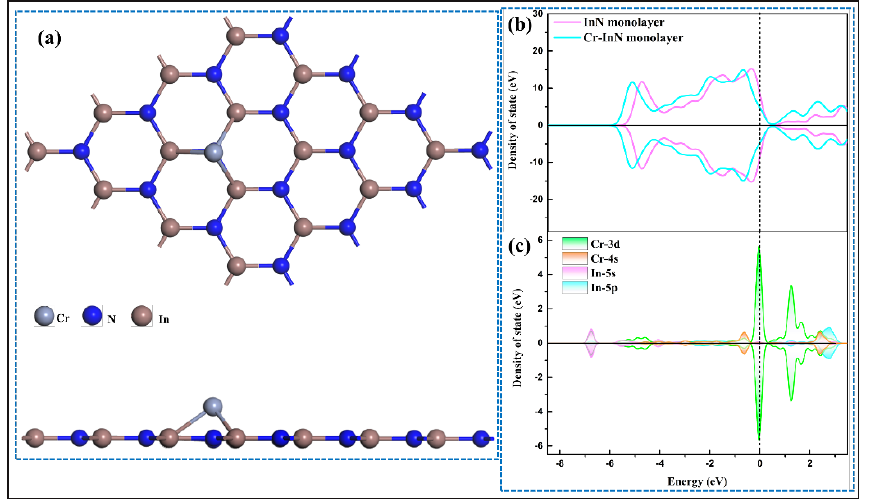
Figure 2. ( a ) Geometric structure, ( b ) TDOS, and ( c ) PDOS of Pd-doped InN monolayer. DOS analysis was used to explore the effect of Cr atom doping on electronic distri- bution. It is believed that TDOS can reflect the electron density distribution of a system; as shown in Figure 2b, the electrons of the Cr – InN monolayer moved to a slightly lower energy direction compared to those of the intrinsic InN monolayer. Moreover, some new states were added to the Cr – InN monolayer, which narrowed the intercept near the Fermi level of the TDOS curve of Cr – InN. These phenomena indicate that the introduction of a Cr dopant reduced the intrinsic band gap of InN and improved the electronic activity of the InN monolayer. Regarding PDOS, the overlap between the curves representing the atomic orbitals indicates the orbital hybridization of atoms, which is usually used to ex- plain the bonding between a dopant and intrinsic material (shown in Figure 2c); the over- lap between the 5s orbital (In-5s) of the In atom and the Cr-3d orbital at -7 eV and the overlap between the In-5p orbital and the Cr-4s orbital in the range from 1 to 4 eV indicate strong orbital hybridization between these two atoms, thus demonstrating that Cr atoms have been successfully incorporated into the InN monolayer system. 3.2. Geometric Structures and Adsorption Energy Analysis for Adsorption System We established and optimized the molecular models of CH 4 , CO, and C 2 H 4 in Dmol 3 , and we carried out adsorption calculations based on the Cr – InN model constructed above. It is obvious that there were many possible ways for each gas to adsorb on the Cr – InN monolayer. In order to figure out the optimal adsorption structure of each gas, different approaching atoms and adsorption angles were used to obtain all possible adsorption structures, the E ads and Q t of which were compared. The selected adsorption structures for the three gases with the optimal parameters in the system are shown in Figure 3, and the E ads and adsorption distance corresponding to each structure are shown in Figure 4. CO and C 2 H 4 all were found to be quite close to the Cr atoms of the Cr – InN mono- layer; the adsorption distance were 1.85 and 1.794 Å , respectively. At the same time, the absolute values of E ads of these two adsorption systems were quite large, reaching − 5.074 and − 6.093 eV, respectively. These phenomena preliminarily indicate that the Cr – InN monolayer exhibits an extremely strong absorbability of CO and C 2 H 4 gases. However, the adsorption ability of InN on CH 4 , with an adsorption energy of 0.652 eV, was found to be relatively high, and its adsorption distance was also the largest of the three systems. An additionally interesting phenomenon is that here, the adsorption distance was rela- tively small in the system with large absolute value of adsorption energy, which might indicate that for an adsorption system, the greater the adsorption energy value, the stronger the interaction force.